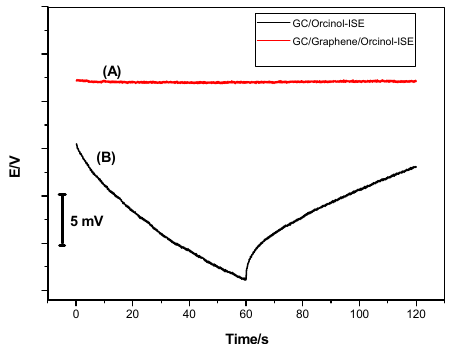
Figure 6. Chronopotentiograms for (A)GC / Gr / MIP / AA-ISE and (B) GC / MIP / AA-ISE under the constant currents of ± 1 nA in 1.0 × 10 − 3 M solution. Table 1. Performance characteristics of MIPs based sensors for orcinol evaluation using 30 mM PBS solution at pH 7.